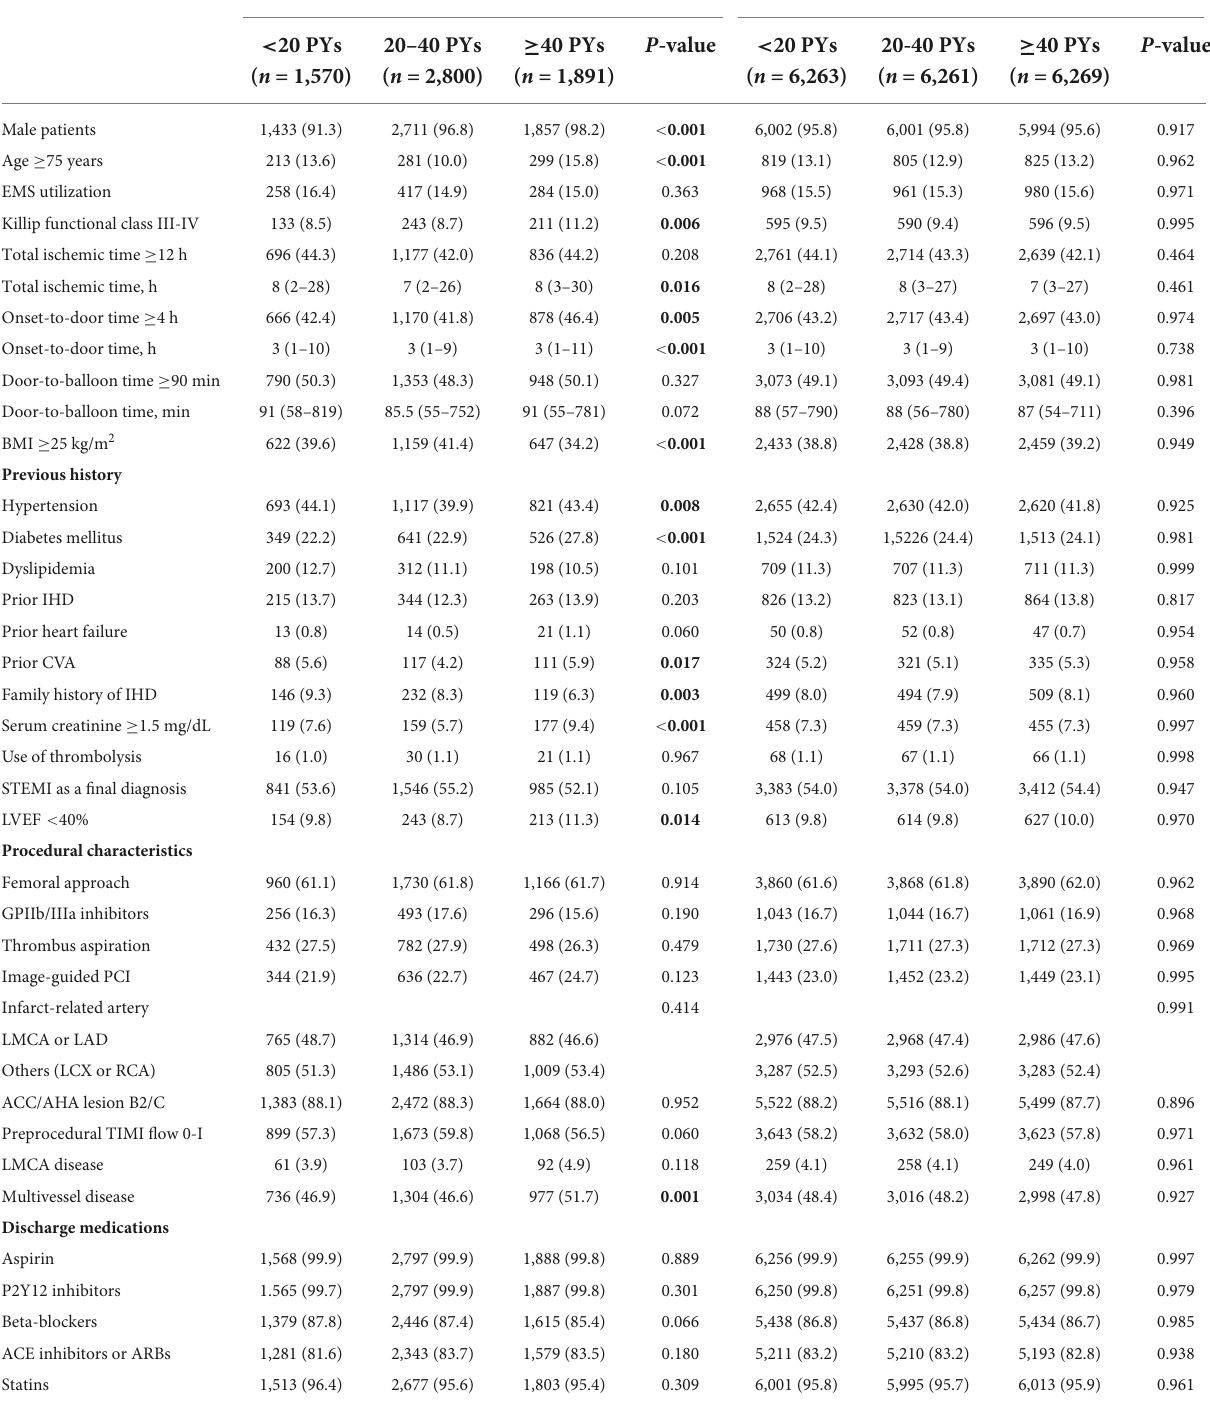
TABLE 2 Baseline characteristics of the smoking group according to smoking pack